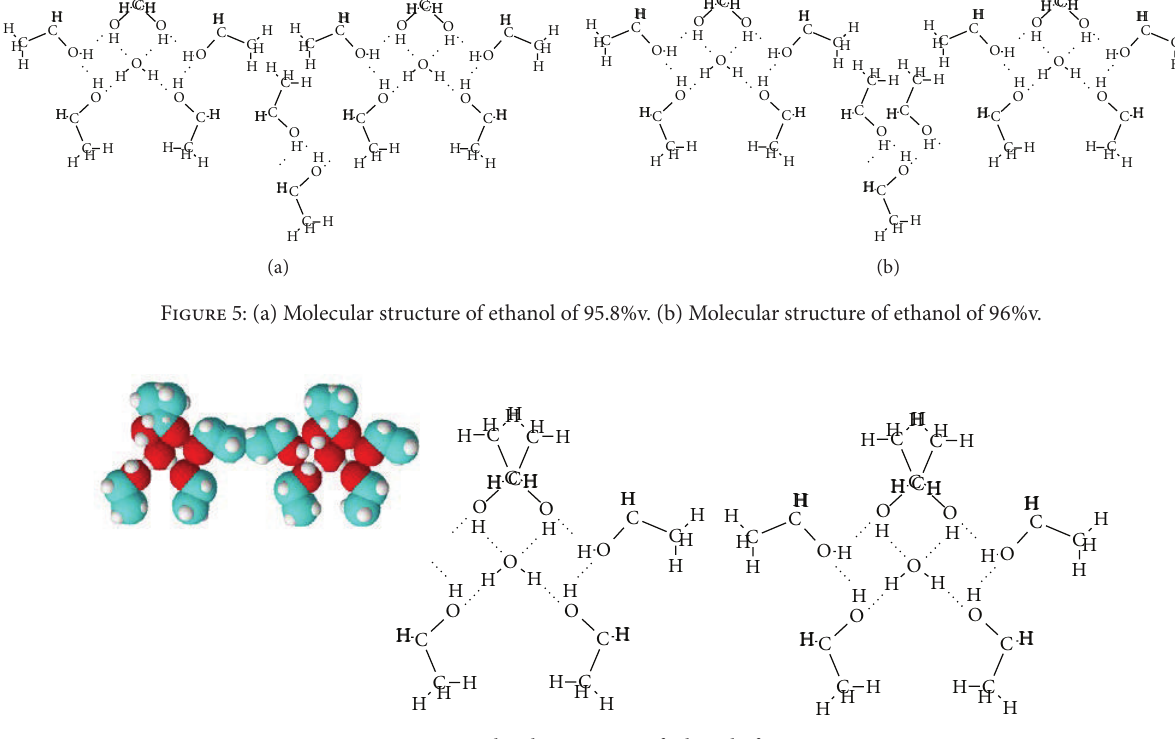
Figure 6: Molecular structure of ethanol of